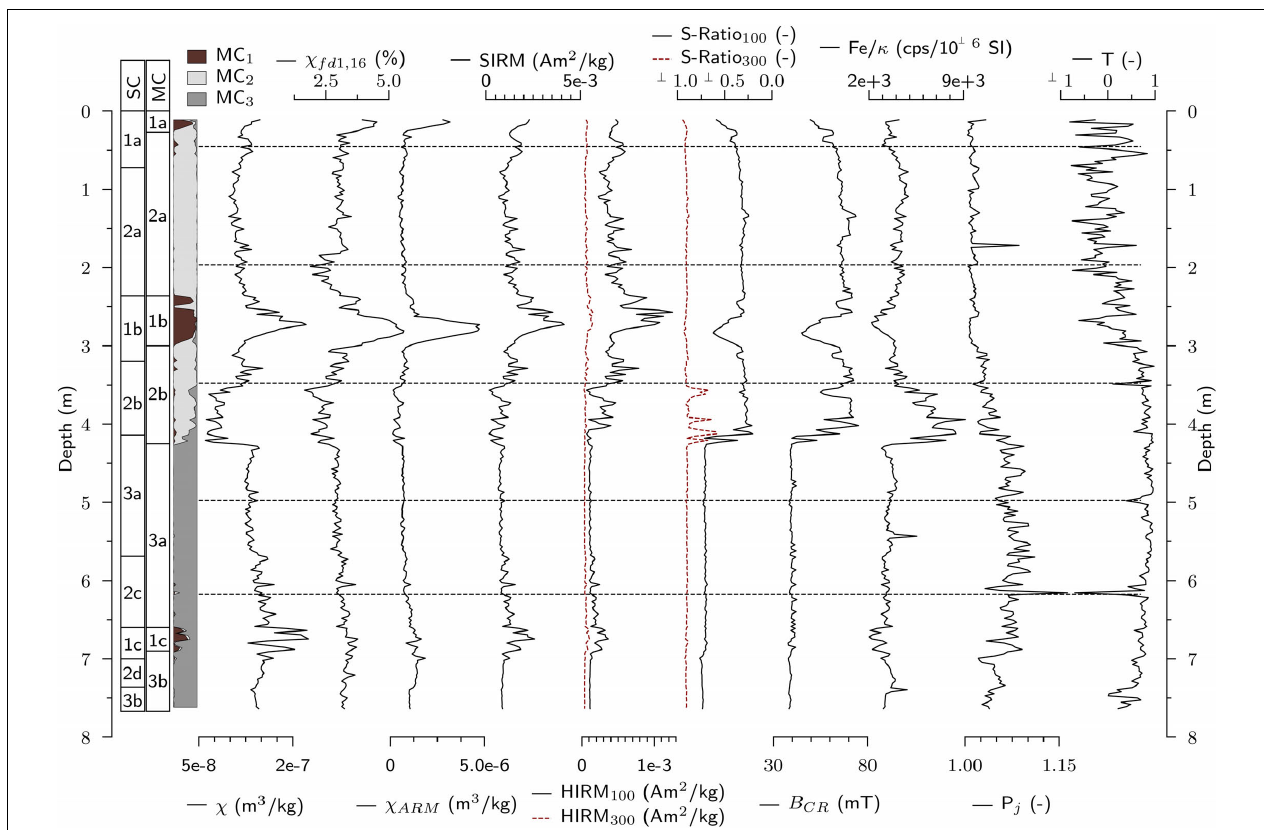
FIGURE 5 | Rock magnetic parameters and results from fuzzy c-means cluster analysis (FCM) based on displayed parameters. From left to right: mass normalised magnetic susceptibility ( χ ), frequency dependent magnetic susceptibility ( χ fd 1 , 16 ), mass normalised susceptibility of anhysteretic remanent magnetisation ( χ ARM ), saturation remanent magnetisation (SIRM, acquired in 2.5 T), hard isothermal remanent magnetisation from 100 mT (HIRM 100 , solid black line) and 300 mT (HIRM 300 , red dashed line) backfields, S-Ratio from 100 mT (S-Ratio 100 , solid black line) and 300 mT (S-Ratio 300 , red dashed line) backfields, coercivity of remanence (B cr ), ratio of iron over volume magnetic susceptibility (Fe/ κ ), degree of anisotropy (P j ) and shape parameter